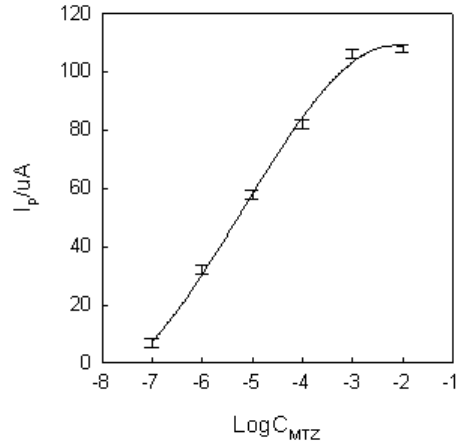
Figure 5. Calibration graph for the MTZ sensor obtained with the MTZ sensor incubated in MTZ solutions of different concentrations followed by voltammetric measurements. Operating potential: - 408 mV vs.